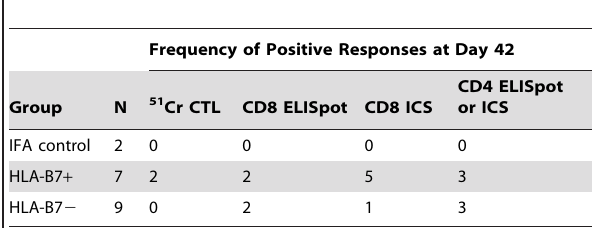
Table 5. T cell responses in subjects who received 2 doses of